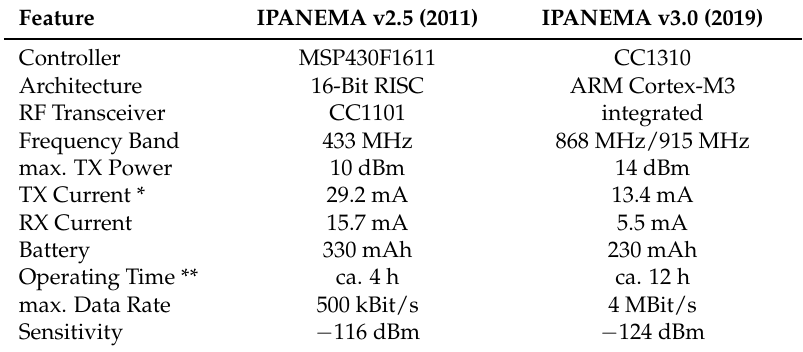
Figure 1. Comparison of the board layouts of the Integrated Posture and Activity Network by MedIT Aachen (IPANEMA) v2.5 ( left ) and v3.0 mainboards ( right ). The most important components are color-coded for each board. Table 1. Comparison of main characteristics of the IPANEMA v2.5 and v3.0